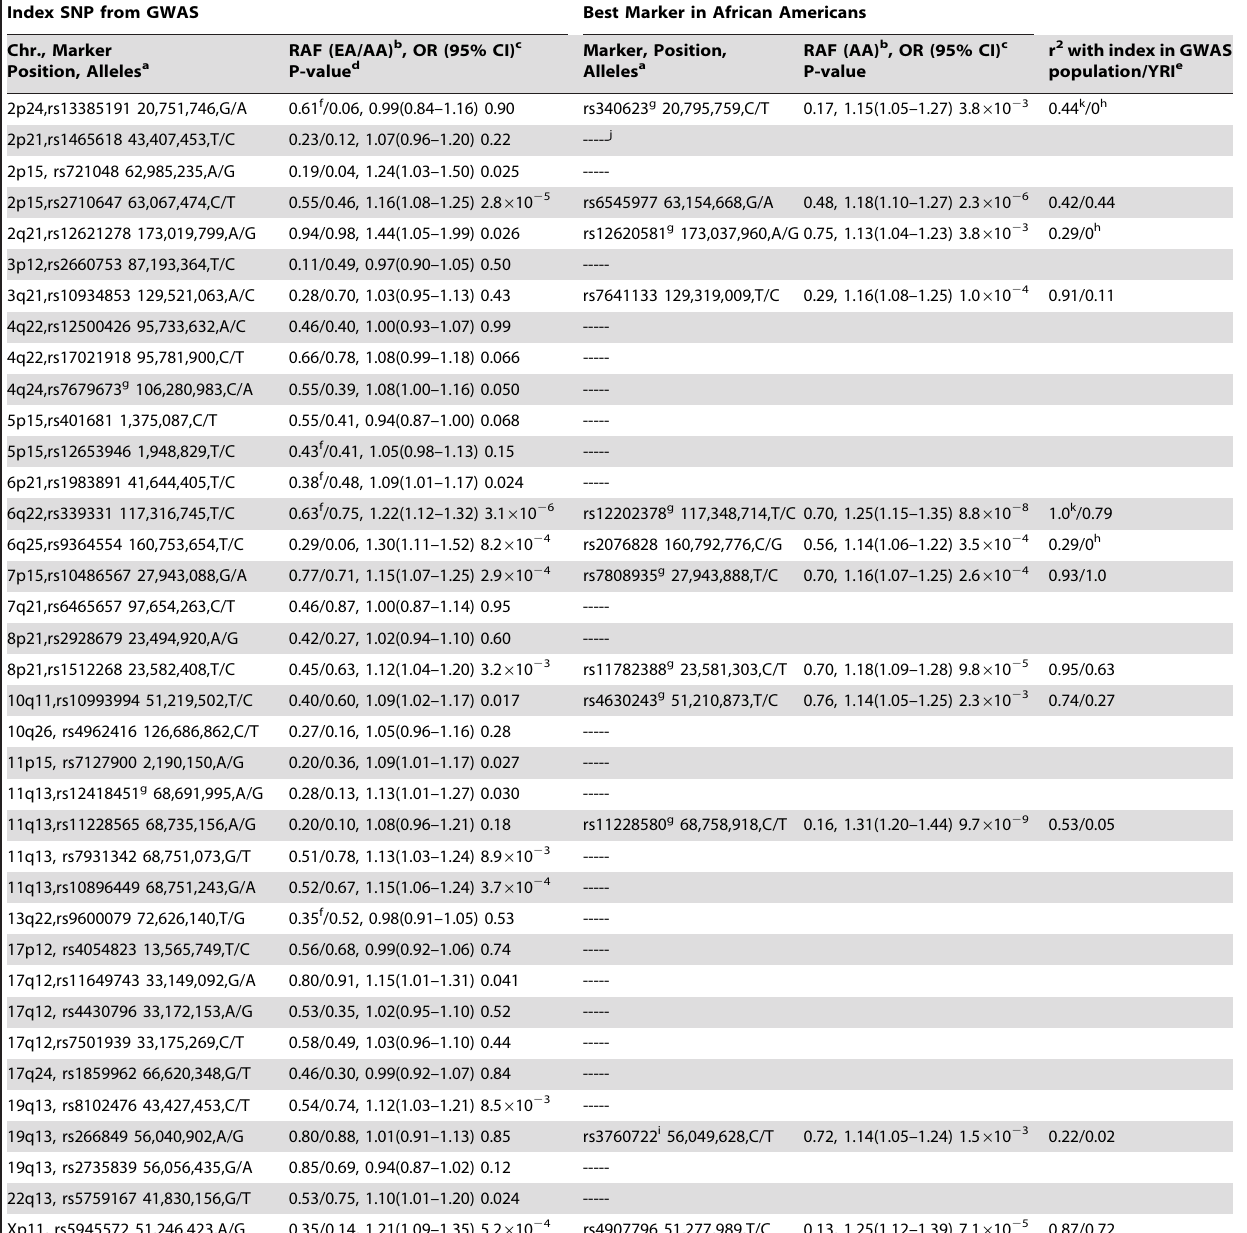
Index SNP from GWAS Best Marker in African